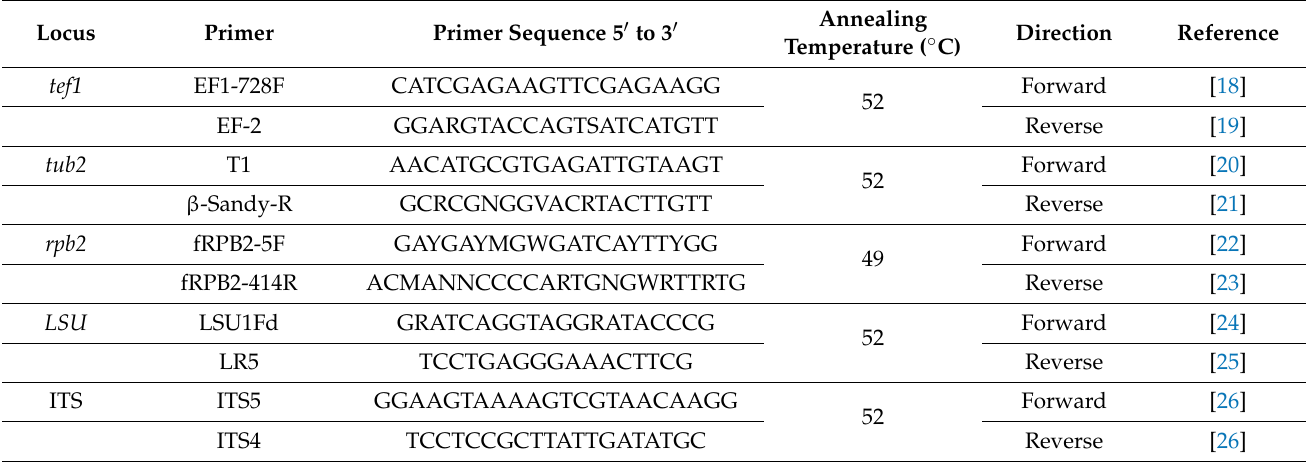
Table 2. Primers, primer sequences, and thermal cycling program for PCR